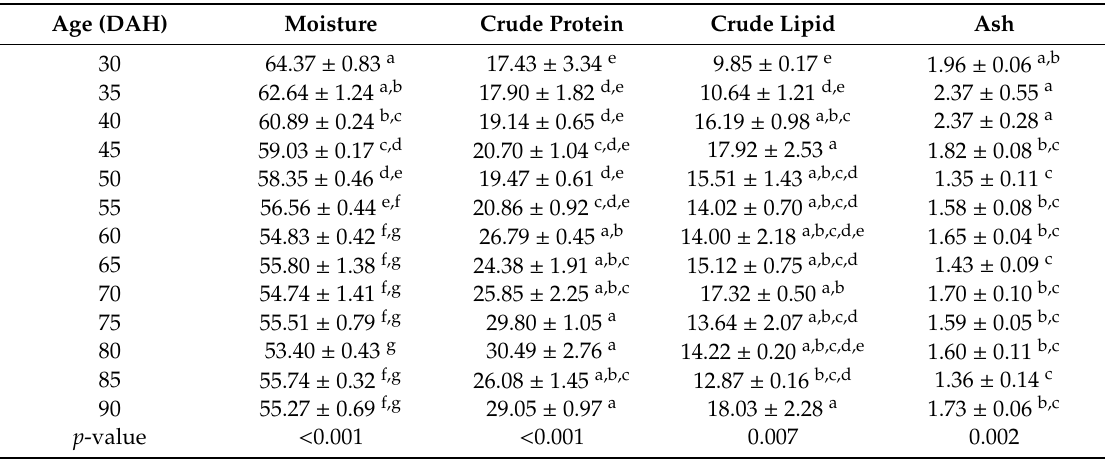
Table 2. Proximate chemical compositions (in % of fresh weight) of mealworm larvae at each sampling